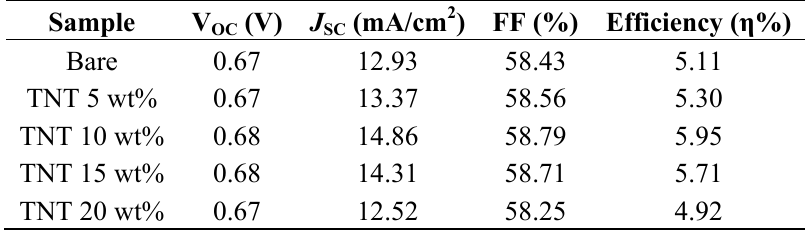
Table 1. The integral photocurrent density ( J and efficiency (η) of DSSCs fabricated using pure TiO particles/TNTs with various